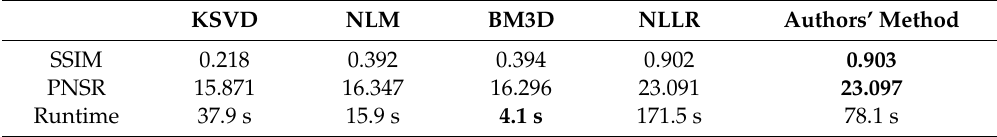
Figure 14. Filtering results based on synthetic data: ( a ) shows the clean synthetic SBP image, ( b ) is the synthetic polluted SBP image, ( c – g ) are the filtered results using KSVD, NLM, BM3D, NLLR, and the proposed method, ( h ) is the clean synthetic SBP image, ( i ) is a synthetic polluted SBP image, ( j – n ) show the filtered results using KSVD, NLM, BM3D, NLLR, and the proposed method. Table 1. Comparison of the different denoising methods applied in Figure 14b. Bold highlights indicate the best results.